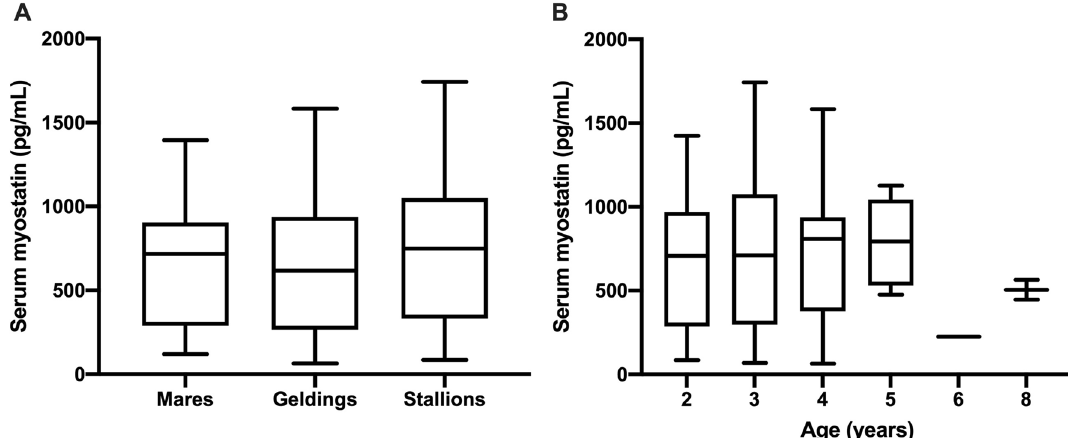
Figure 3. Comparison of serum myostatin concentrations in horses of different sex ( A ) and age ( B ). Boxes represent the median and interquartile ranges and whiskers the range. No significant differences detected (P = 0.14 and 0.72